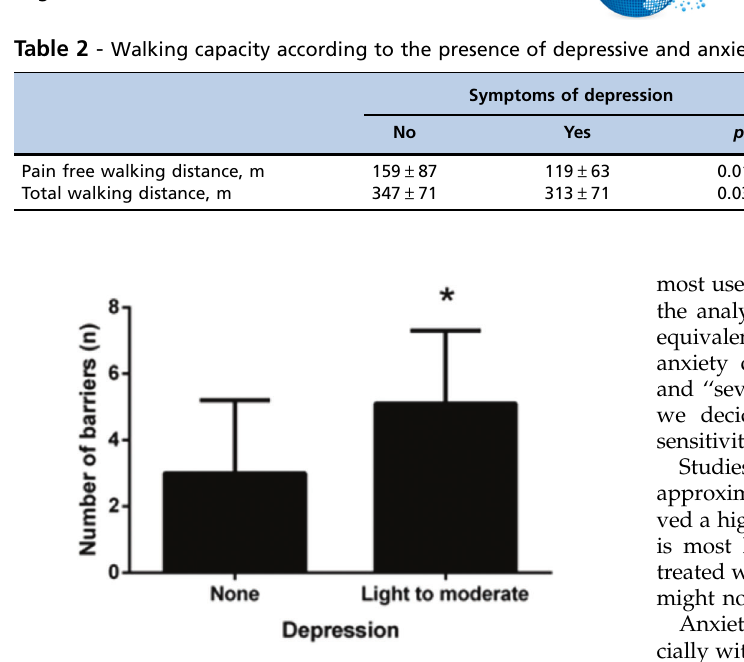
Fig 2 - Comparison of the number of barriers according to the depression symptoms; * p o 0.005.